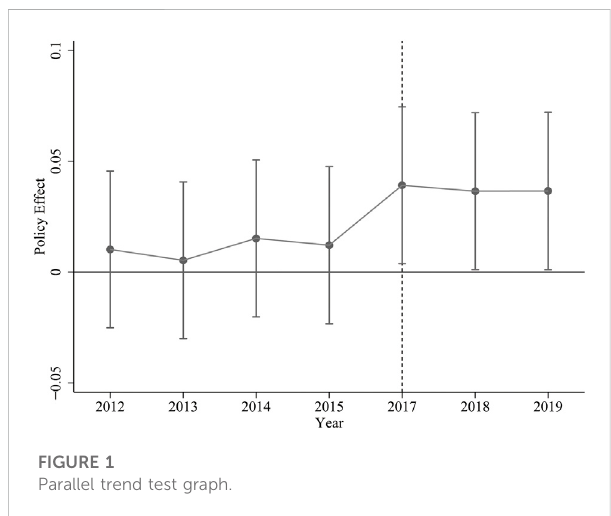
FIGURE 1 Parallel trend test